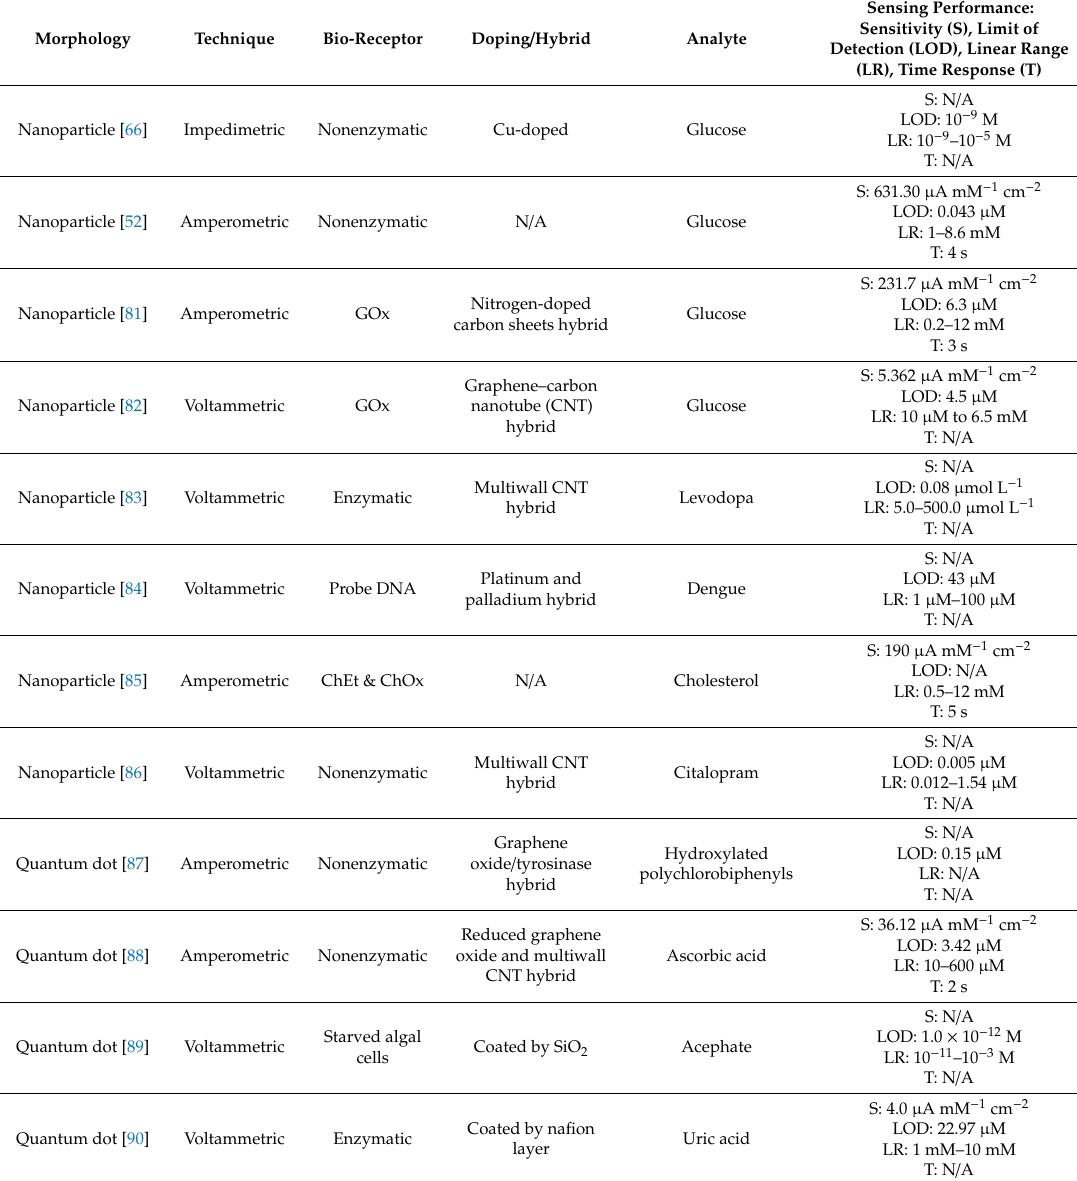
Table 1. Di ff erent techniques of 0-D ZnO-based electrochemical biosensors for various analyte detections, since 2014. Morphology Bio-Receptor Doping / Hybrid Analyte